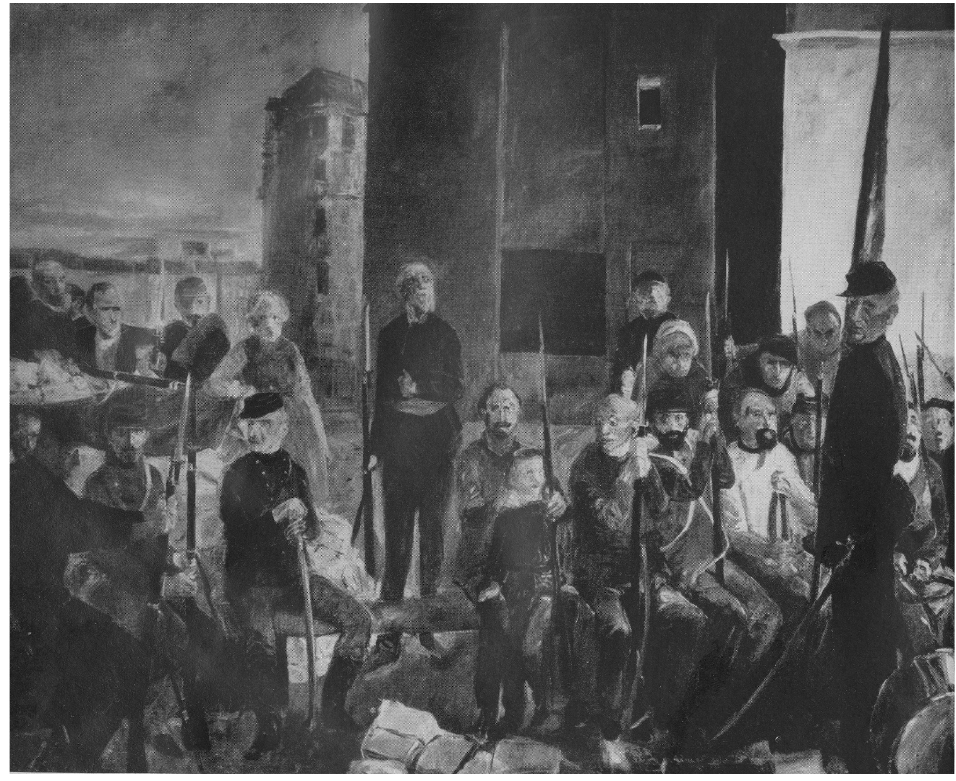
Bernhard Heisig, March Days in Paris I , 1960. Oil on Canvas. 123 x 153 cm. Destroyed through